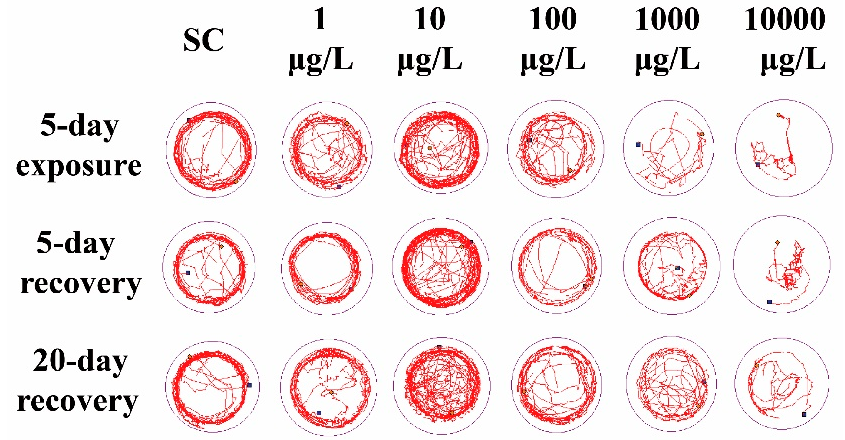
Figure 2. The representative locomotor trajectory in 5 min. Zebrafish larvae in the 10 µ g/L group exhibited significant higher ASS and MMA and lower PLT, while larvae in the 100, 1000 and 10,000 µ g/L groups exhibited significant lower ASS and MMA and higher PLT, compared to the SC group (Figure 3A–C). After 5 days of recovery, these behavioral parameters still did not return to the levels of those in the SC group. After 20 days of recovery, ASS, MMA and PLT in the 100 µ g/L group returned to the control levels, while those in the two highest concentration groups could not recover.